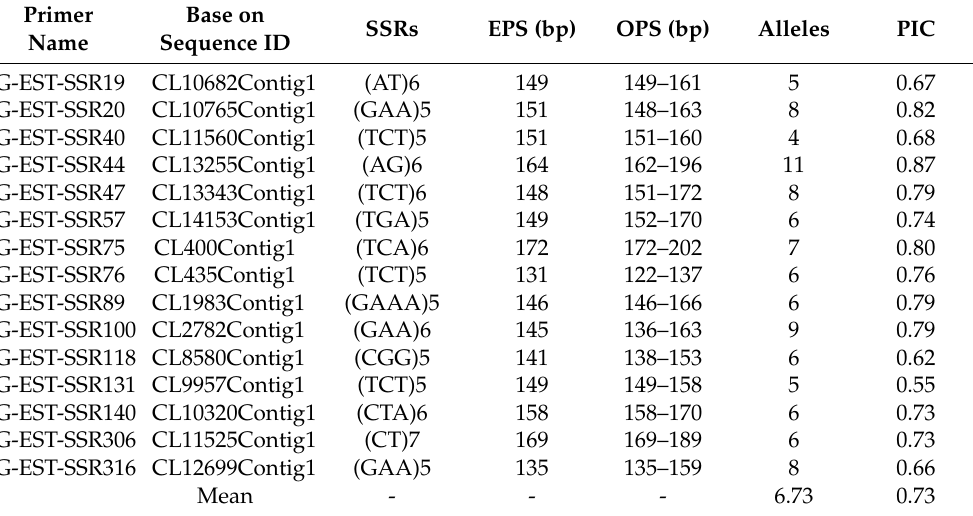
Table 5. Details of 15 genic-SSR loci showing polymorphism among 12 Gynostemma species.